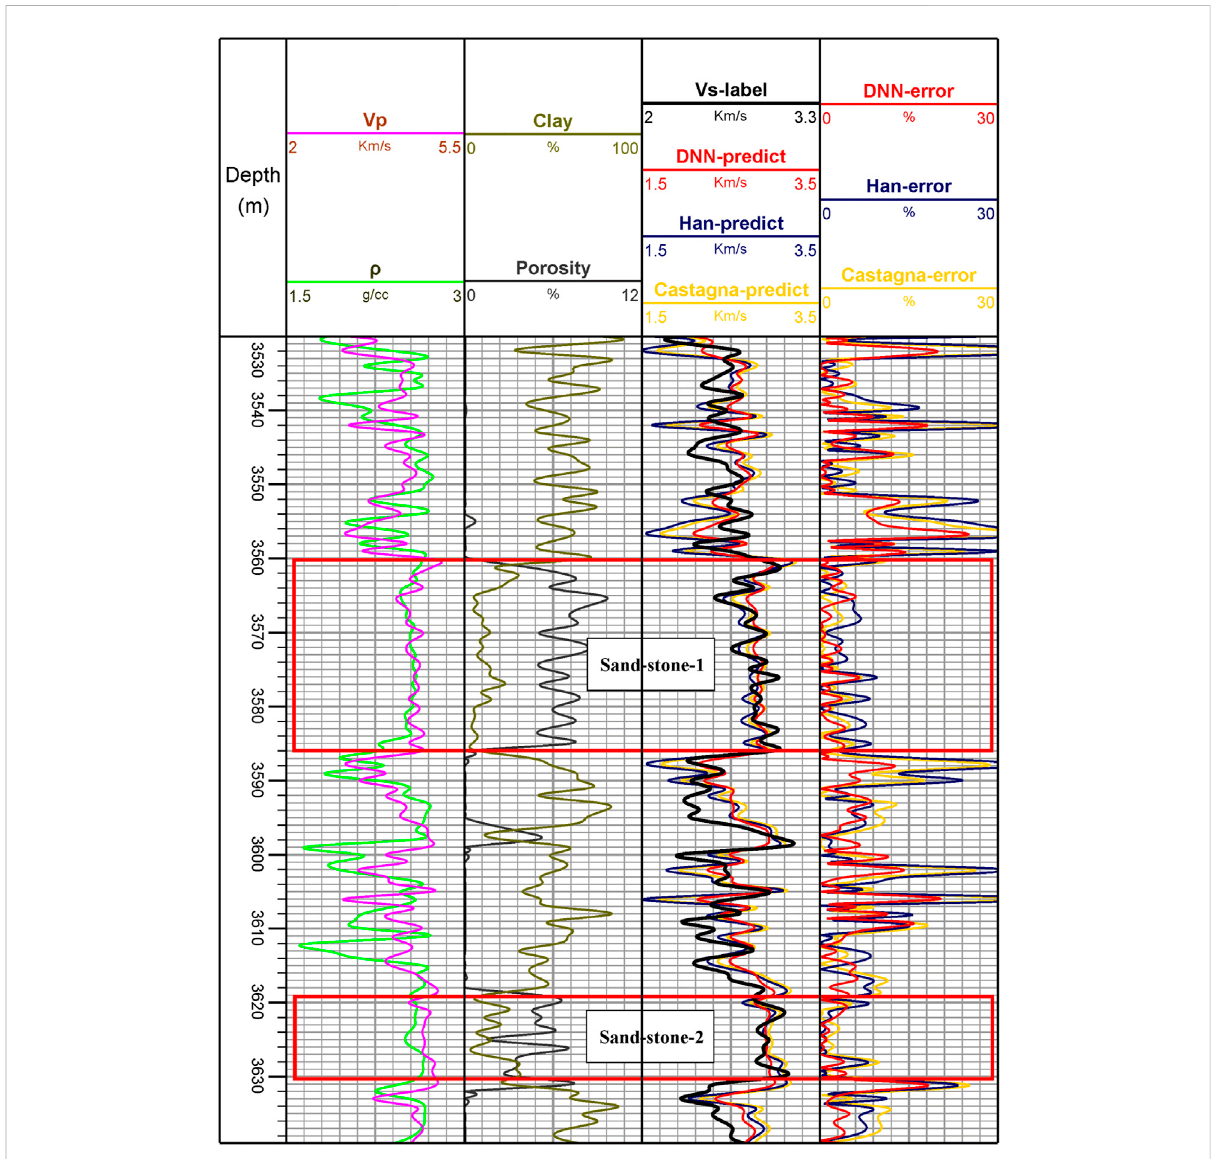
FIGURE 10 Data information of well 3 and S-wave velocity prediction results (Vs-label is the logging S-wave velocity, xx-predict indicates the result predicted using a certain method, and xx-error indicates the corresponding relative error).